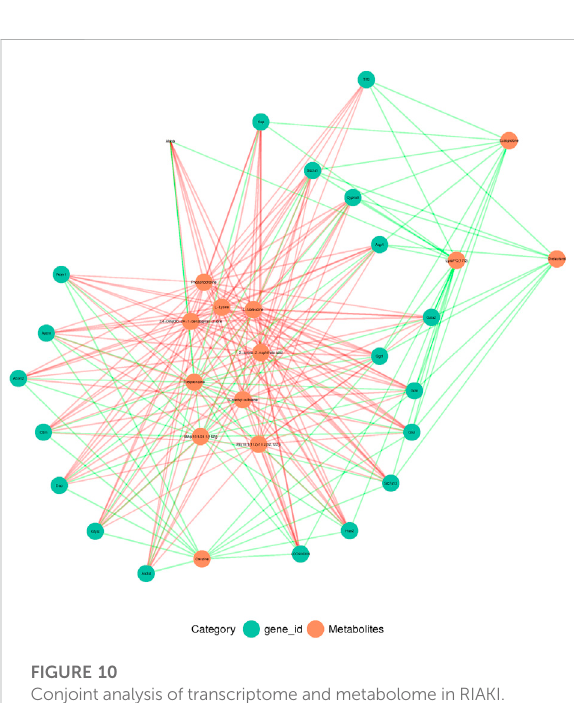
FIGURE 10 Conjoint analysis of transcriptome and metabolome in RIAKI. Green and red circles represent corresponding DEGs and metabolites,respectively. Greenandredlinesindicatepositive and negative correlations between DEGs and metabolites,